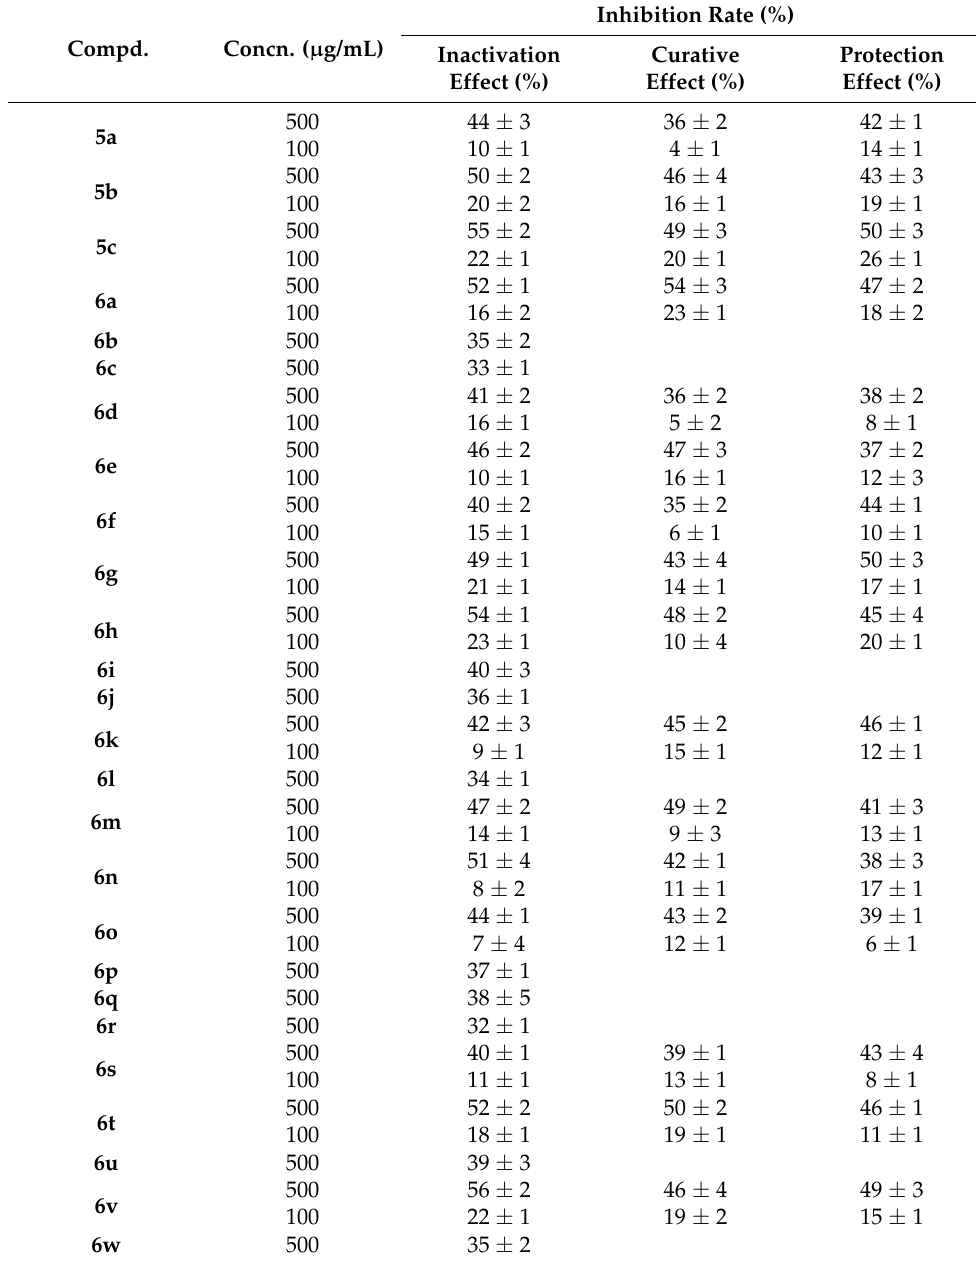
Table 1. In vivo anti-TMV activity of synthesized compounds 5a − 5c , 6a − 6aa 1 .